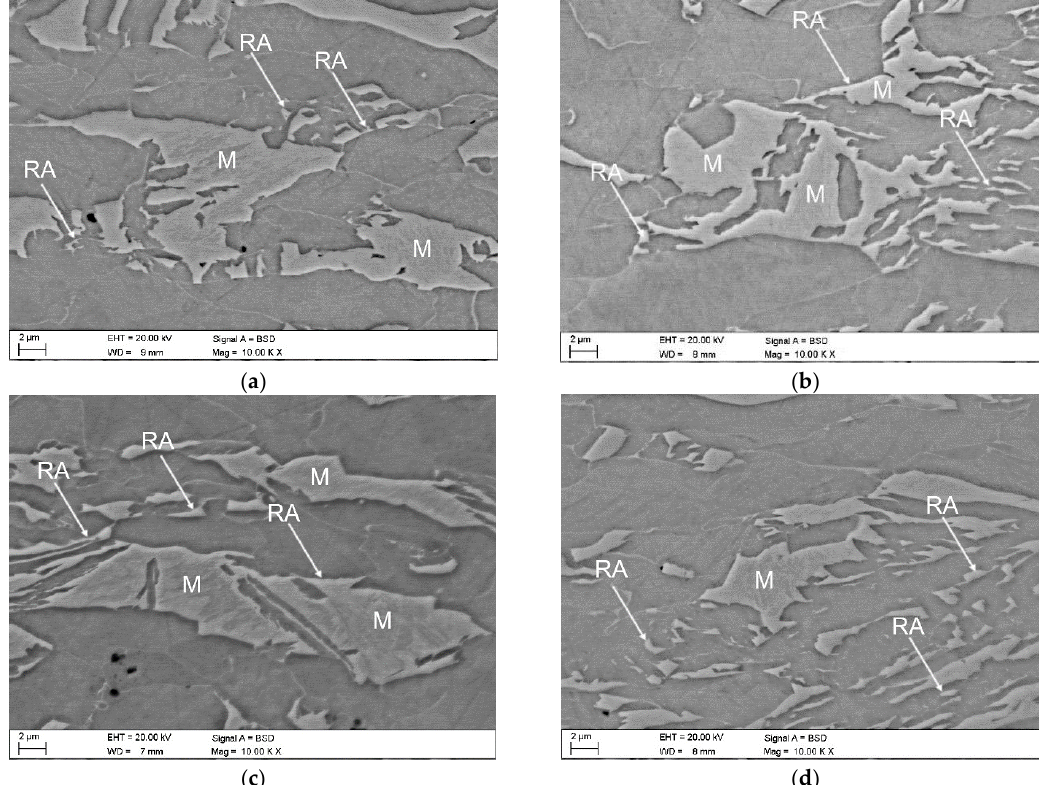
Figure 7. SEM micrographs of specimens deformed at temperatures: 20 ( a ), 60 ( b ), 100 ( c ), and 200 °C ( d ).